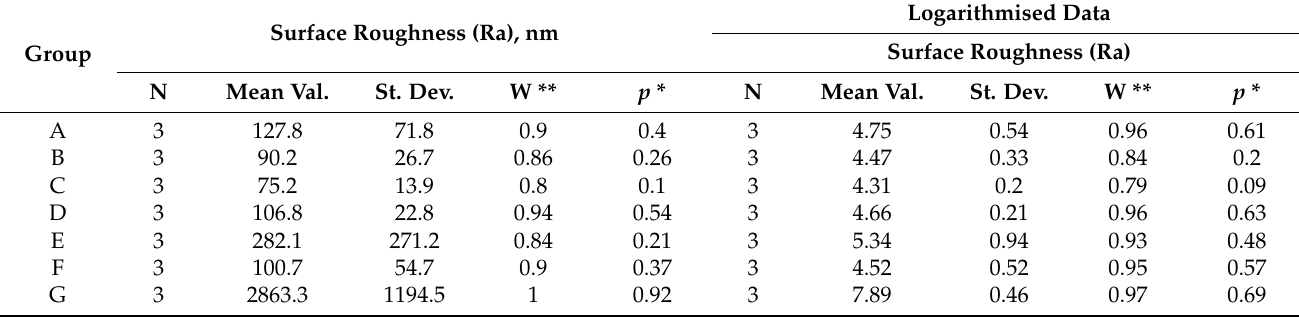
Table 2. Test of normality of surface roughness data (Ra).